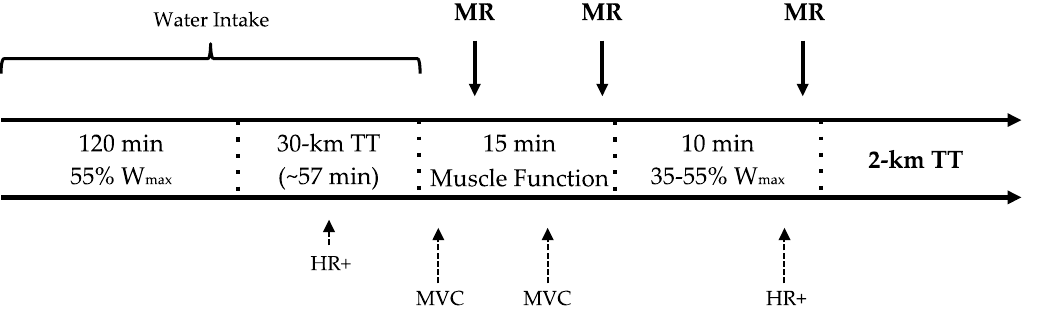
Figure 1. Experimental trial design with dependent measures. Water intake bracket indicates when only water was provided; HR+ with short arrow indicates heart rate (HR), rating of perceived exertion (RPE), and glucose measurements taken midway through the 30 km time trial (TT) prior to the mouth rinse (MR) intervention; HR+ with tall arrow indicates HR, RPE, and glucose measurements taken to determine the effects of the MR intervention; MVC, maximum voluntary.